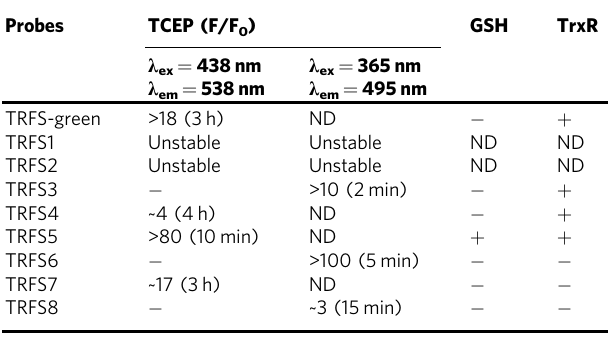
Table 2 Summary of optical properties of TRFS1-8